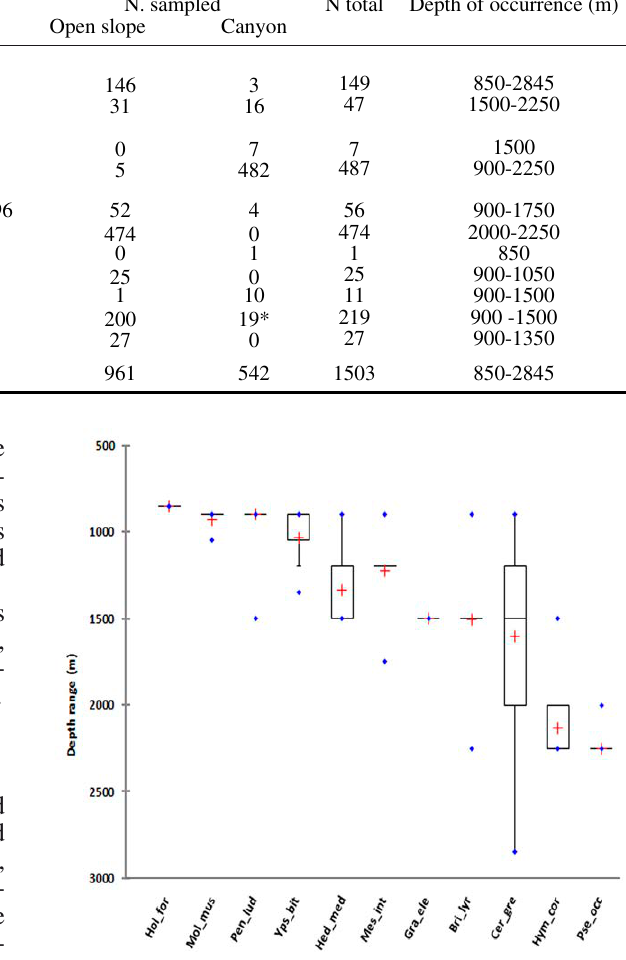
Fig. 2. – Bathymetric distribution and densities of echinoderms sampled in present study. The top and bottom of each box-plot represent 75% (upper quartile) and 25% (lower quartile) of all val- ues, respectively. The horizontal line is the median. The ends of the whiskers represent the 10th and 90th percentiles. Cross marks represent means and blue spots maximum and minimum depth of occurrence. Species codes: Hol_for, Holothuria ( Panningothuria ) forskali ; Mol_mus, Molpadia musculus ; Pen_lud, Penilpidia lud- wigi ; Yps_bit, Ypsilothuria bitentaculata ; Hed_med, Hedingia mediterranea ; Mes_int, Mesothuria ( Allantis ) intestinalis ; Gra_ele, Gracilechinus elegans ; Bri_lyr, Brissopsis lyrifera ; Cer_gre, Ceramaster grenadensis ; Hym_cor, Hymenodiscus coronata ; and Pse_occ, Pseudostichopus